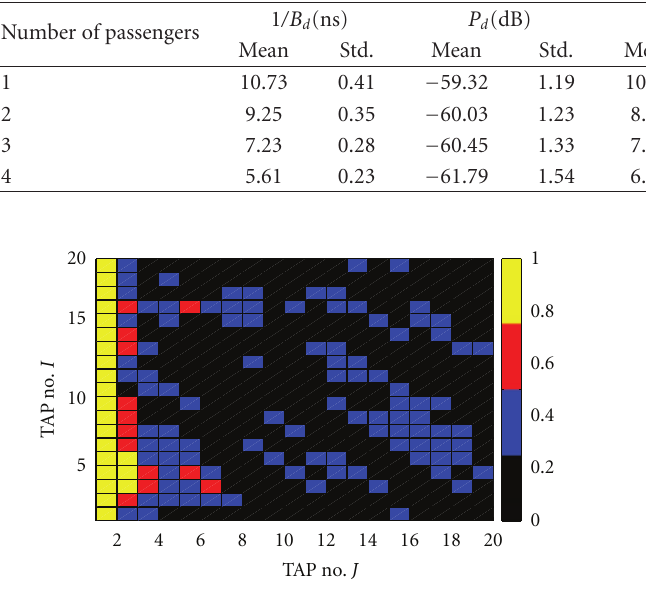
Figure 6: Delay correlation of the di ff use component. Only correlation coe ffi cient with adjacent taps have significant values (above 0.5).